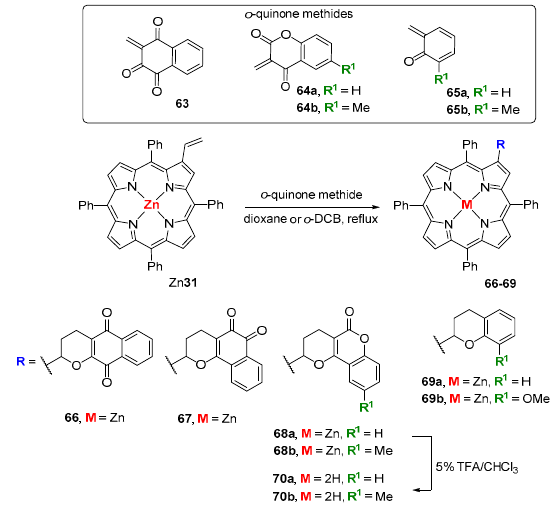
Figure 14. Compounds obtained from the reaction of natural-type porphyrin derivatives with ortho -quinone methides [139].